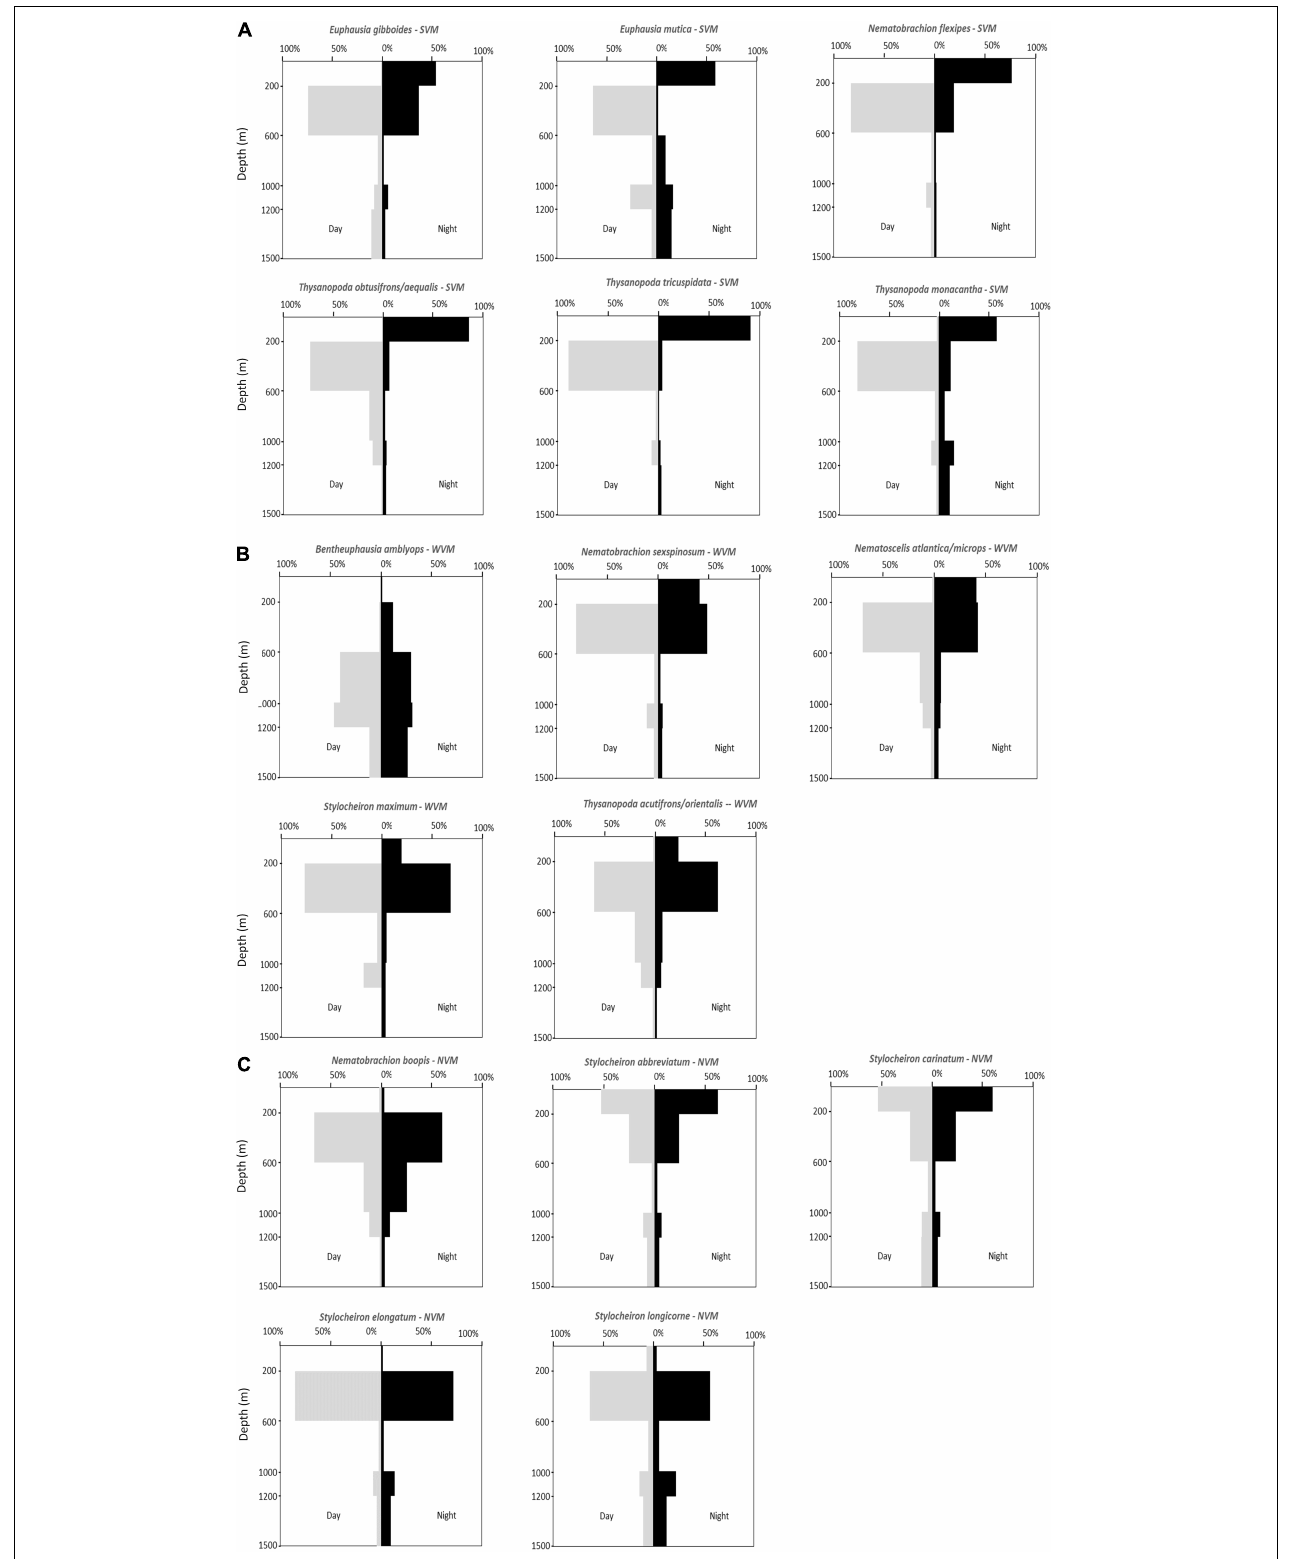
FIGURE 7 | Vertical distribution patterns of abundant euphausiid species. (A) Strong vertical migrators (SVM). (B) Weak vertical migrators (WVM). (C) Non-vertical migrators (NVM).